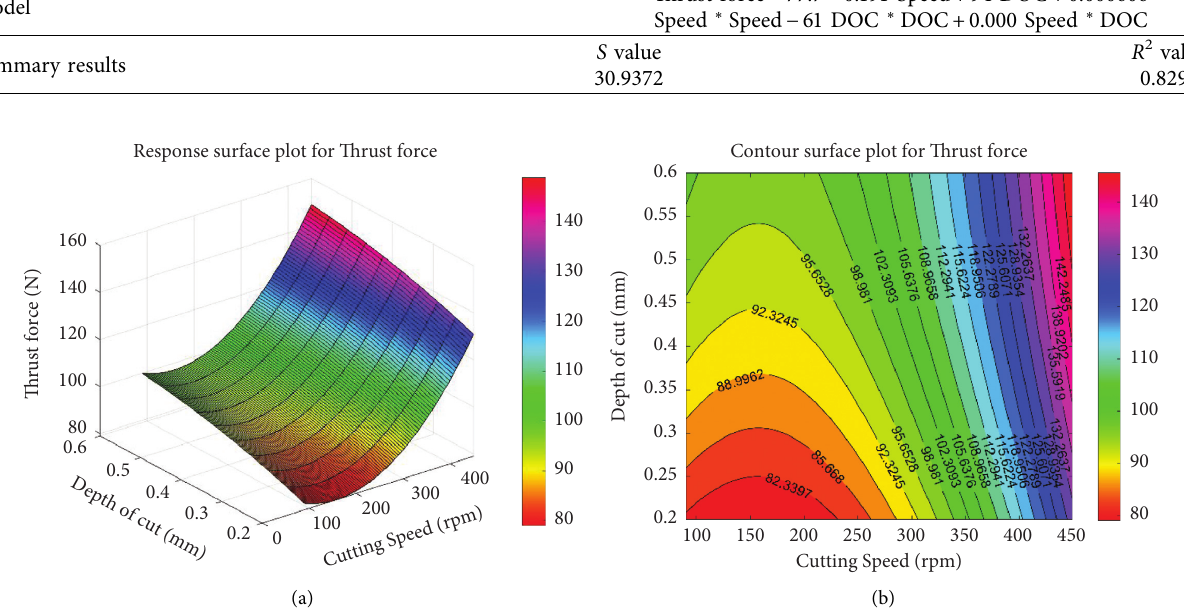
Figure 10: (a) Response surface graph for Thrust force (depth of cut vs. cutting speed). (b) Contour surface plot for Thrust force (depth of cut vs. cutting speed). Table 15: Regression model and summary results for Thrust force.